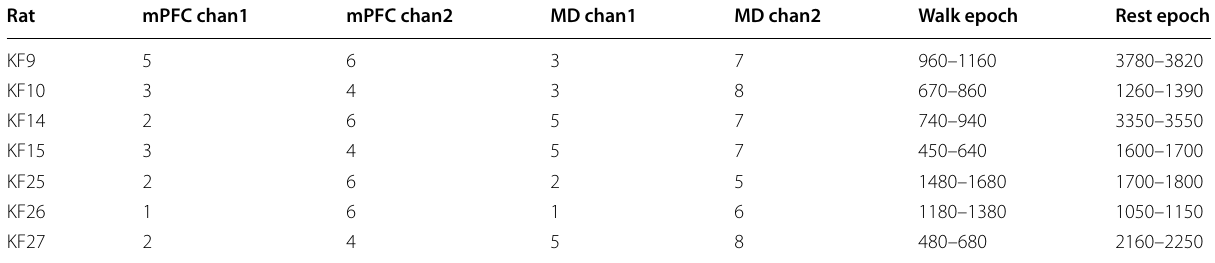
Table 4 Guide to determine best channels and epochs to use of baseline walk and rest recordings in medial prefrontal cortex (mPFC) and the mediodorsal (MD) thalamus, as mentioned in the file named “Coherence Phase Plot Guide” Rat mPFC chan1 mPFC chan2 MD chan1